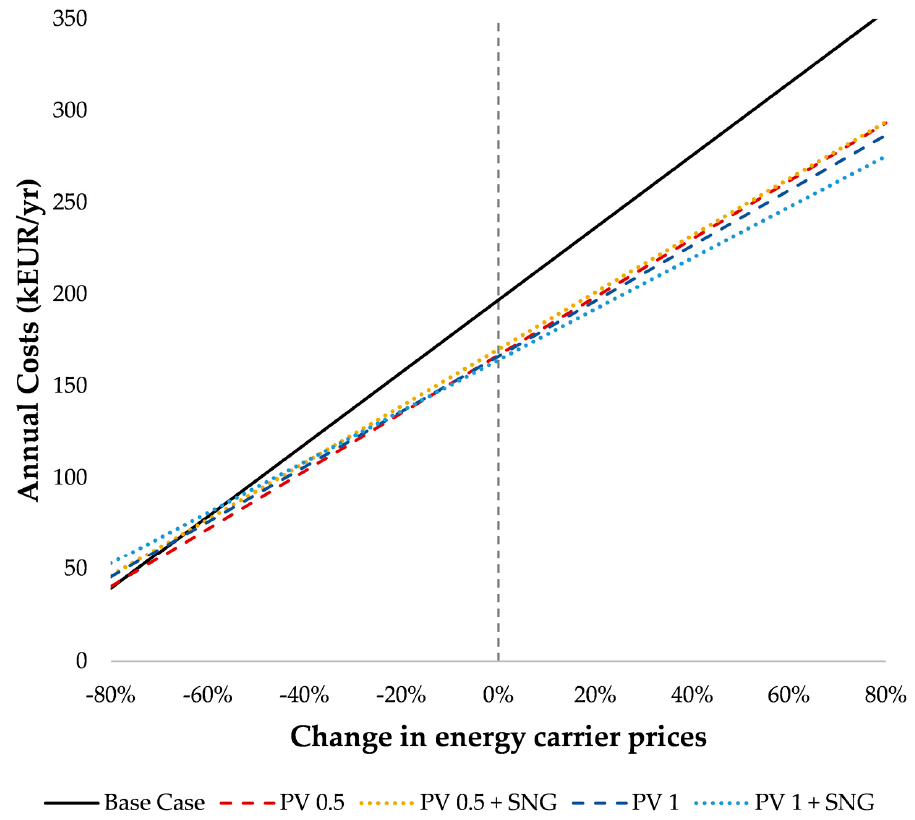
Figure 11. Sensitivity analysis of annual costs by changing the energy carrier prices.